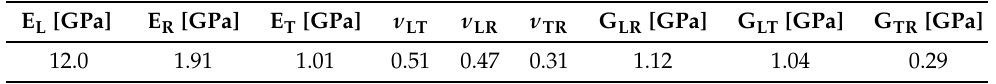
Table 1. Nominal elastic properties of pine wood [27].